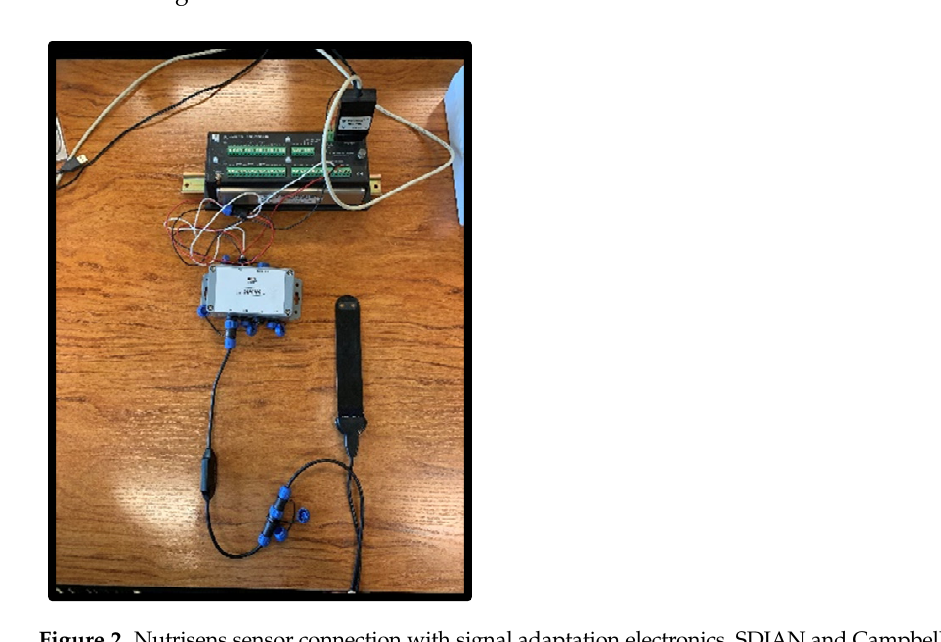
Figure 2. Nutrisens sensor connection with signal adaptation electronics, SDIAN and Campbell CR10X.